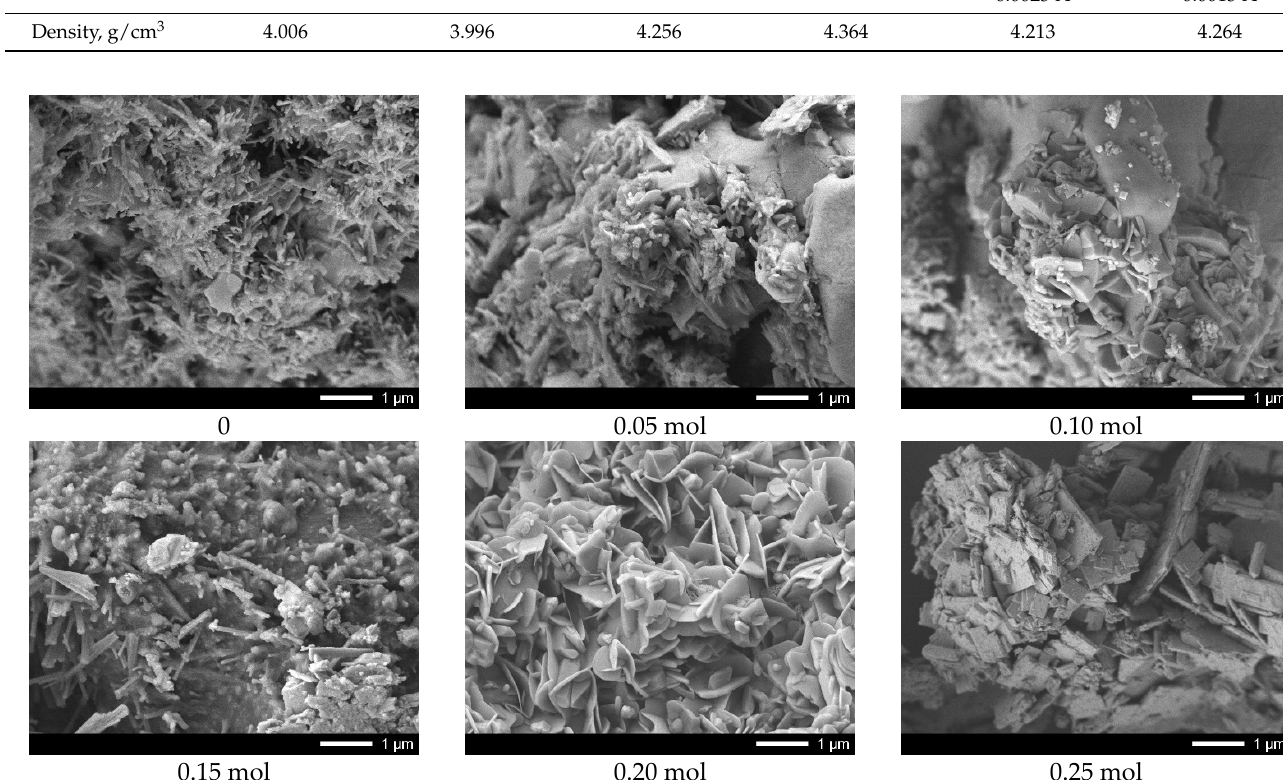
Figure 3. SEM images of synthesized CaTiO 3 ceramics doped with lanthanum (La).